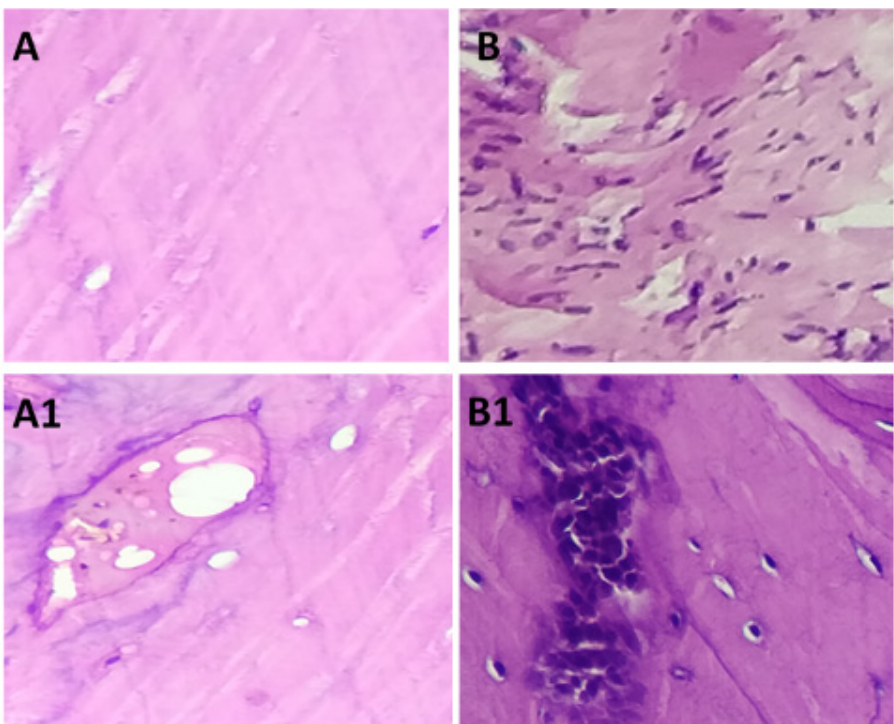
Figure 10. Histological images of ( A ) without implantation at 4 weeks ( B ) HAP-HPC-PLA at 4 weeks ( A1 ) without implantation at 8 weeks ( B1 ) HAP-HPC-PLA at 8 weeks.